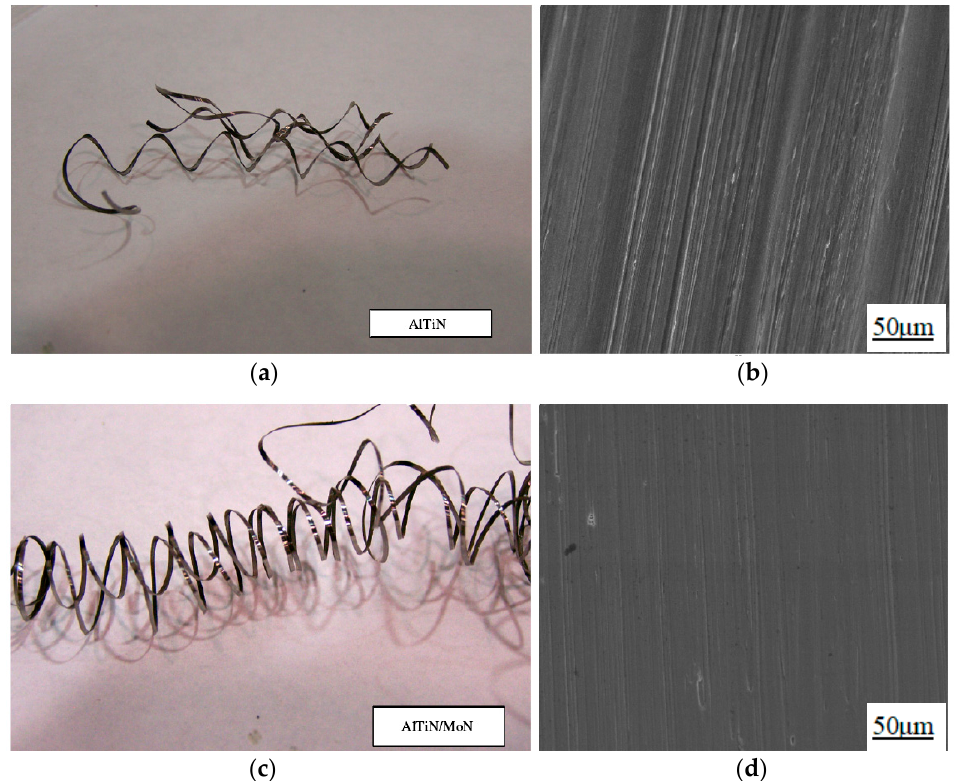
Figure 3. Type and morphology of the underlying surface of the various coatings during processing of the 718 alloy: ( a ) the AlTiN coated chips, ( b ) the AlTiN coating surface morphology, ( c ) the AlTiN/MoN coated chips, ( d ) the AlTiN/MoN coating surface morphology [20]. Reprinted with permission from [20]; 2006 Elsevier.